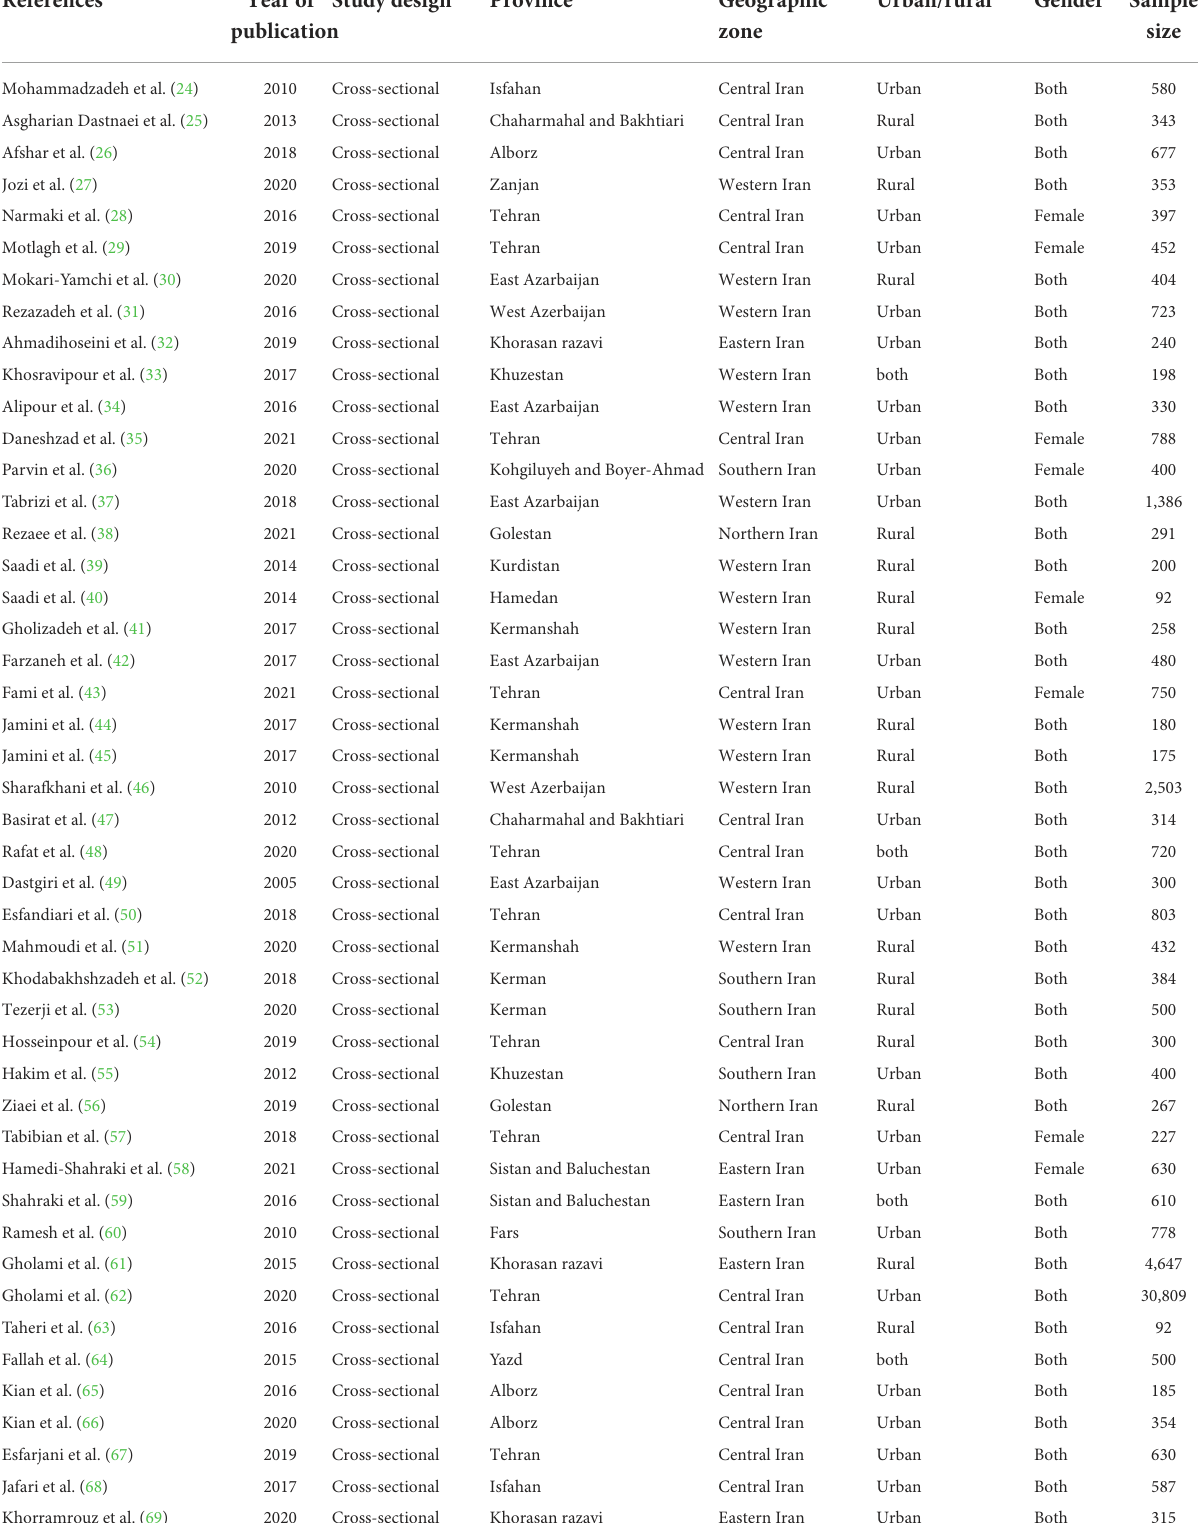
TABLE 1 Characteristics of the included studies in the systematic review and